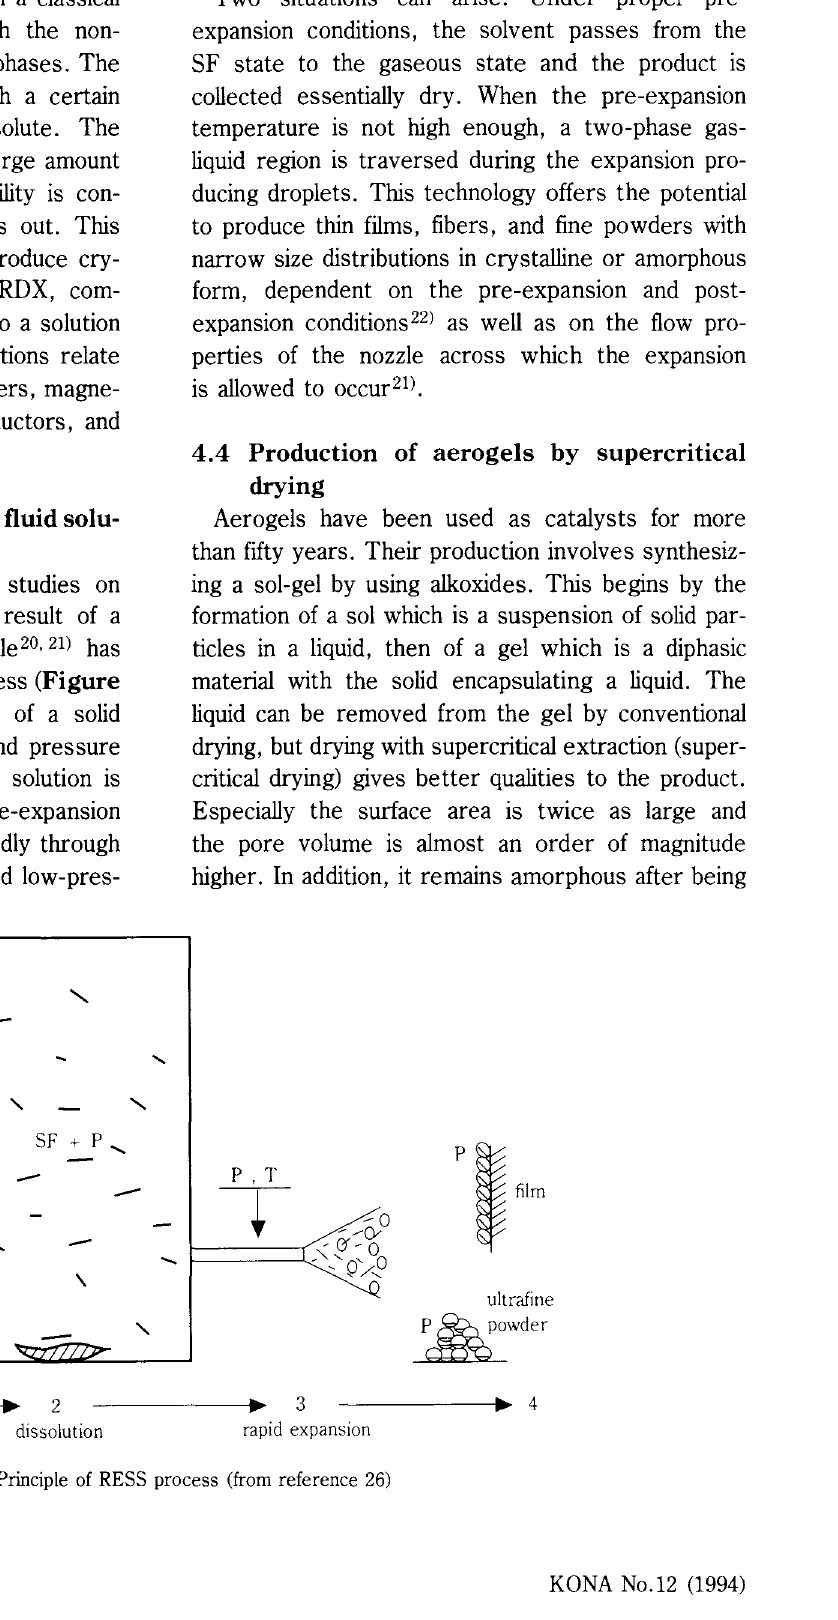
Fig. 2 Principle of RESS process (from reference